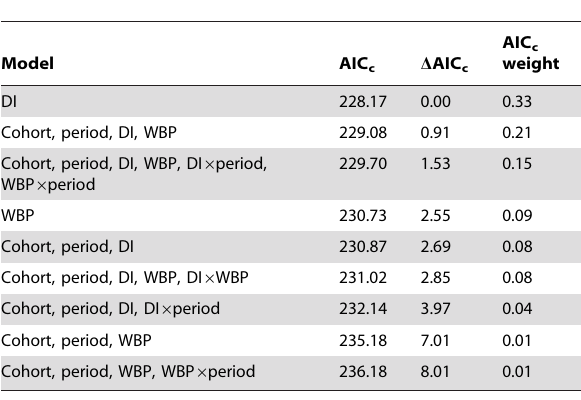
Figure S1 Changes in an index of grizzly bear population density in the Greater Yellowstone Ecosystem, 1983–2012. Relative grizzly bear population density in 1983 (A), 1993 (B), 2003 (C), and 2012 (D). Yellowstone National Park (inner black line) and the grizzly bear Recovery Zone (outer blue line) are represented on each panel for reference.